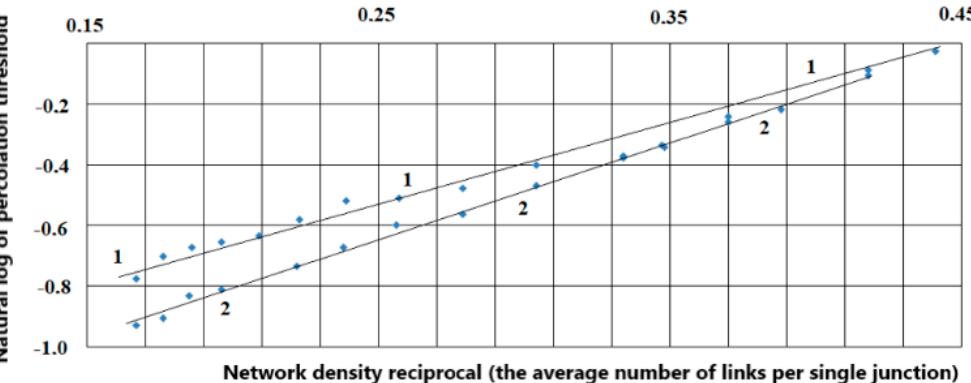
Figure 6. Dependency of natural log percolation threshold value ( lnP ( x )) on accidental planar structures from the reciprocal of density (1/ x ).